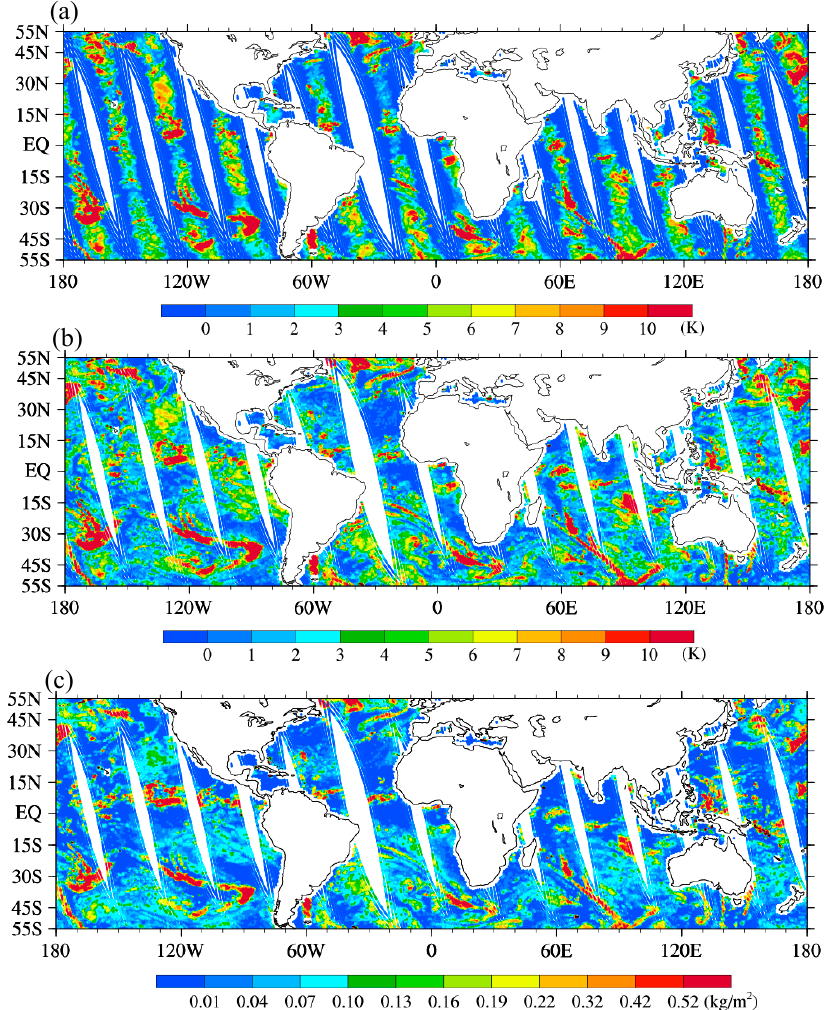
Figure 7. Spatial distributions of ( a ) O-B and ( b ) ξ O − B of MetOp-B AMSU-A channel 3, as well as ( c ) cloud liquid water path from ascending nodes on 15 July 2014.